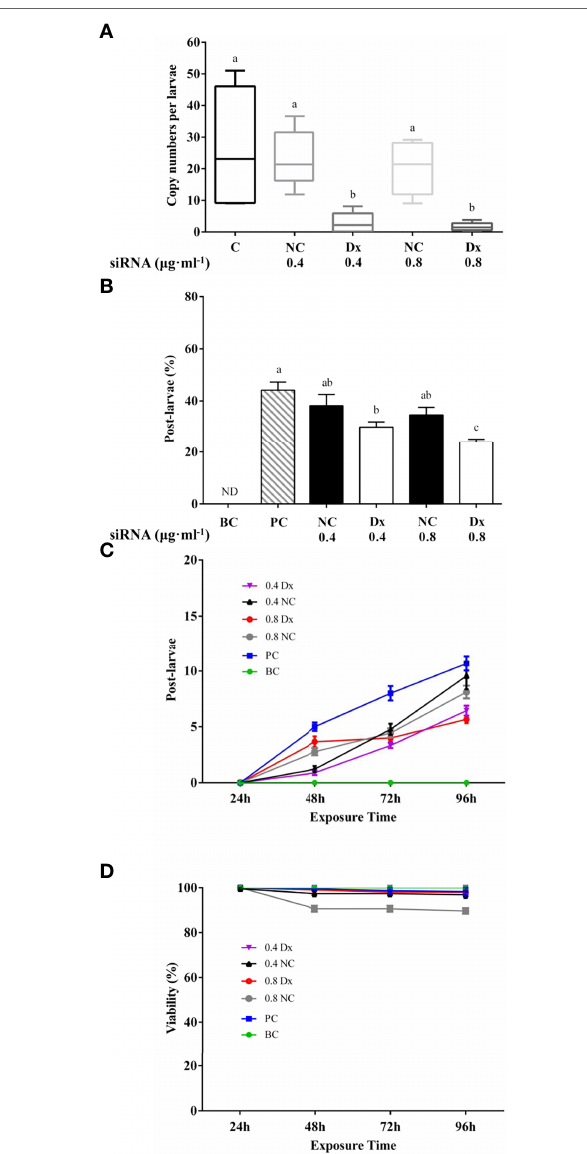
FIGURE 3 | Effect of electroporation on McDx expression (A) , metamorphosis (B) , the cumulative number of post-larvae (C) and viability (D) of the hard- shelled mussel larvae. (A) Quantitative RT-PCR expression of the McDx in electroporated and control larvae. Significant differences (p < 0.05) are represented by different letters above the columns. C: control; NC: negative control (electroporated with the non-sense siRNA, 0.4 and 0.8 μg ml-1); Dx: electroporated with the McDx siRNA (0.4 and 0.8 μg ml-1). (B) Percentage of larvae metamorphosed at 96 h. The results are represented as mean ± SEM of nine experiments containing 20 larvae per replicate. Different letters above the bars indicate statistically significant differences (p < 0.05). BC: blank control; PC: positive control; NC: negative control (electroporated with the non-sense siRNA, 0.4 and 0.8 μg ml-1); Dx: electroporated with the McDx siRNA (0.4 and 0.8 μg ml-1). (C) The cumulative number of post-larvae at each time point of the metamorphosis assay (EPI induction) in control and McDx siRNA, non-sense siRNA electroporated pediveliger larvae. The results are presented as the mean ± SEM of nine experimental replicates (each containing 20 individuals). (D) Viability of mussel larvae in the metamorphosis assay (EPI induction) after electroporation with McDx siRNA or non-sense siRNA.